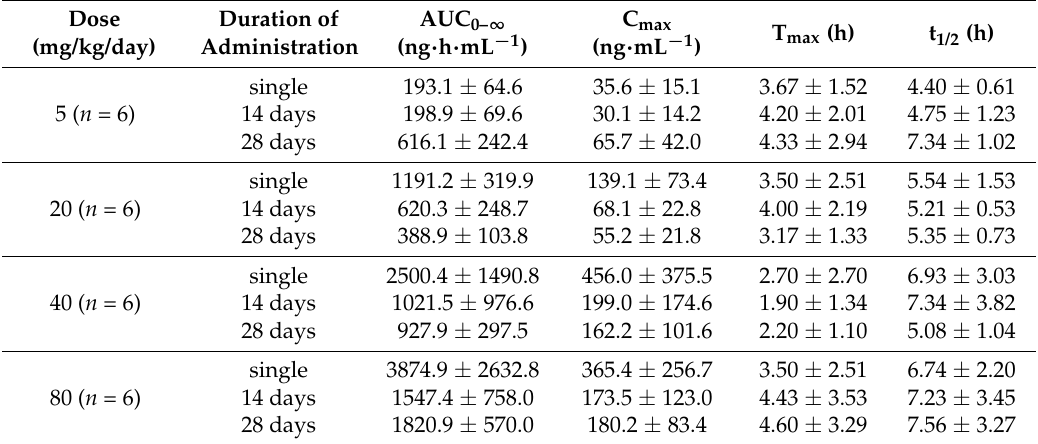
Table 6. Mean (± SD) toxicokinetic parameters of HZ1006 after oral administration in doses of 5, 20, 40 and 80 mg/kg/day to Beagle dogs.